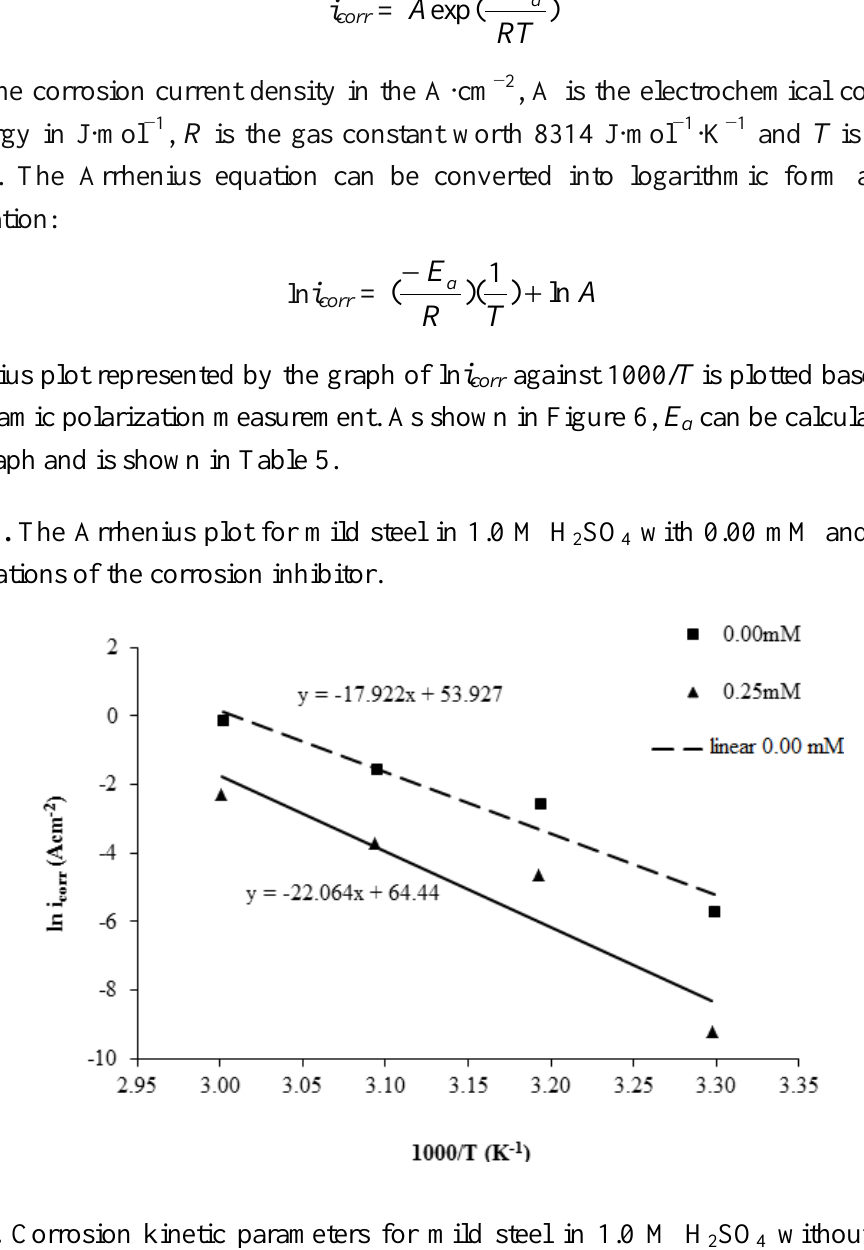
SO without and with 2 4